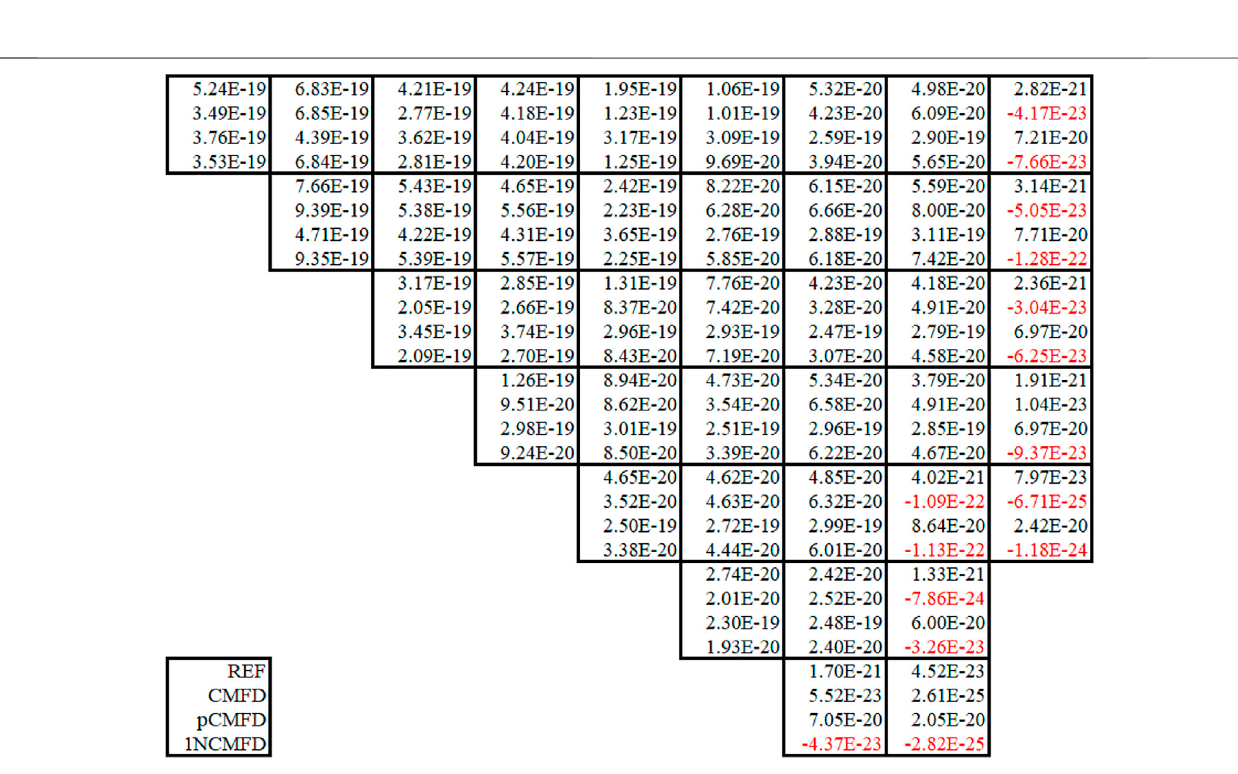
FIGURE 10 | Thermal group numerical adjoint fl ux for the KWU 2D problem.